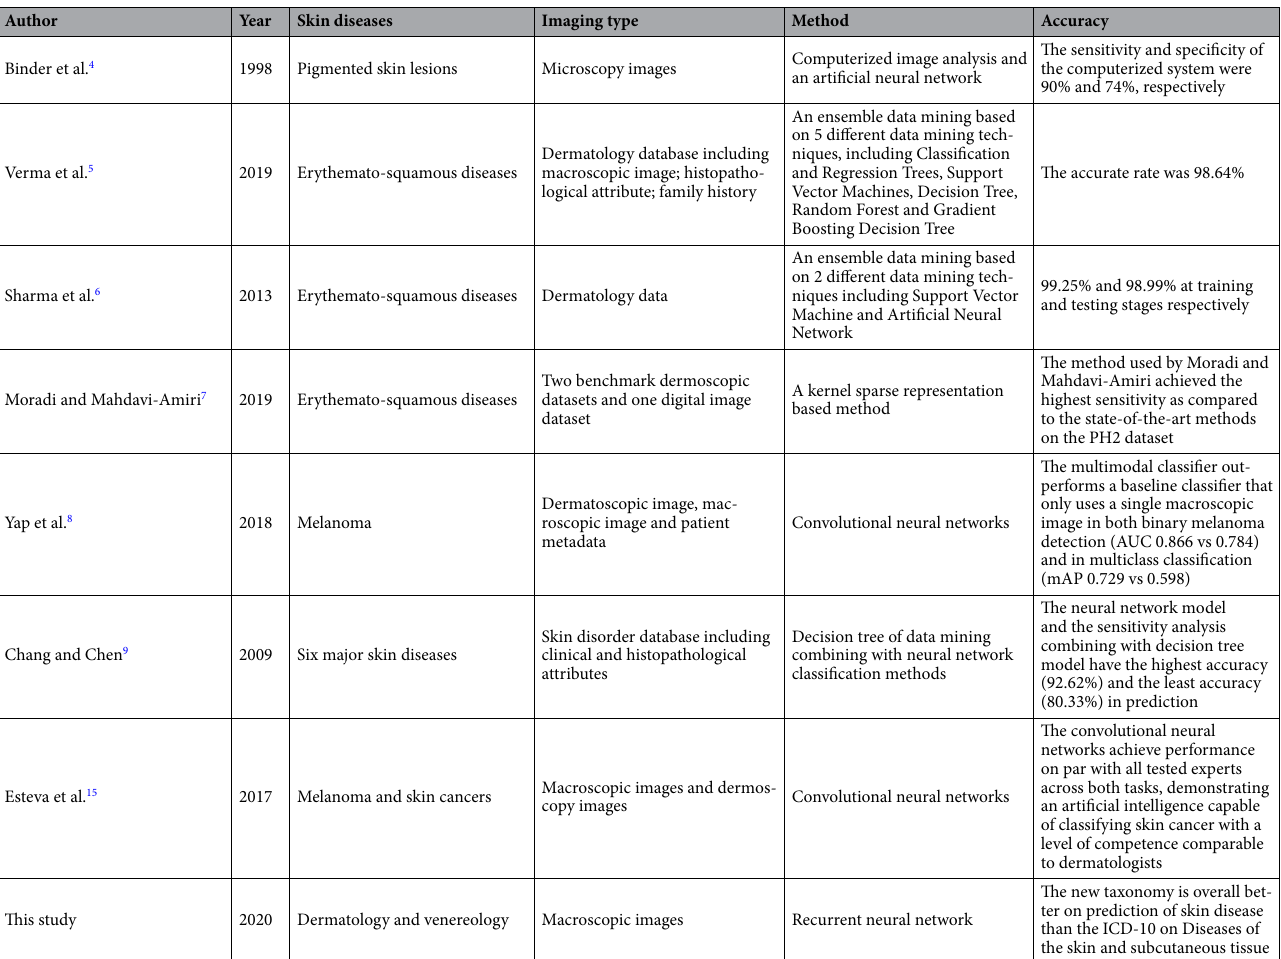
Table 1. Investigations focusing on skin disease classification using artificial intelligence